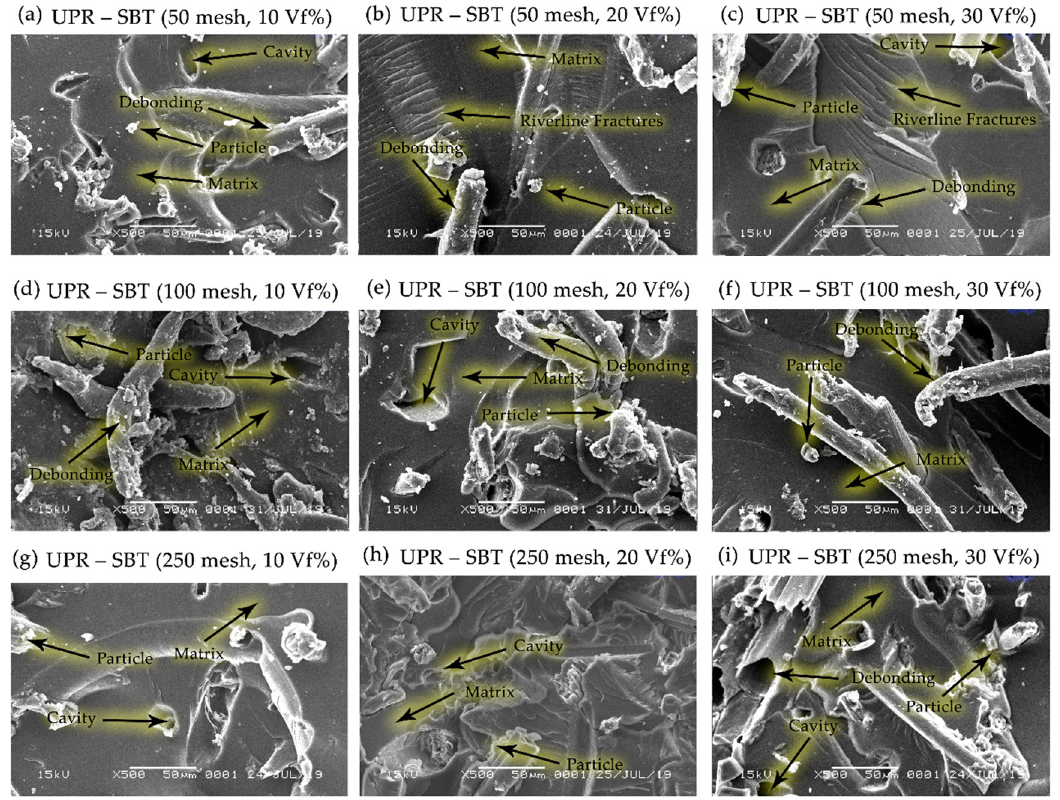
Polymers 2021 , 13 , x FOR PEER REVIEW Figure 13. Comparison of the tensile strength of bamboo–polyester composites from previous and current research.